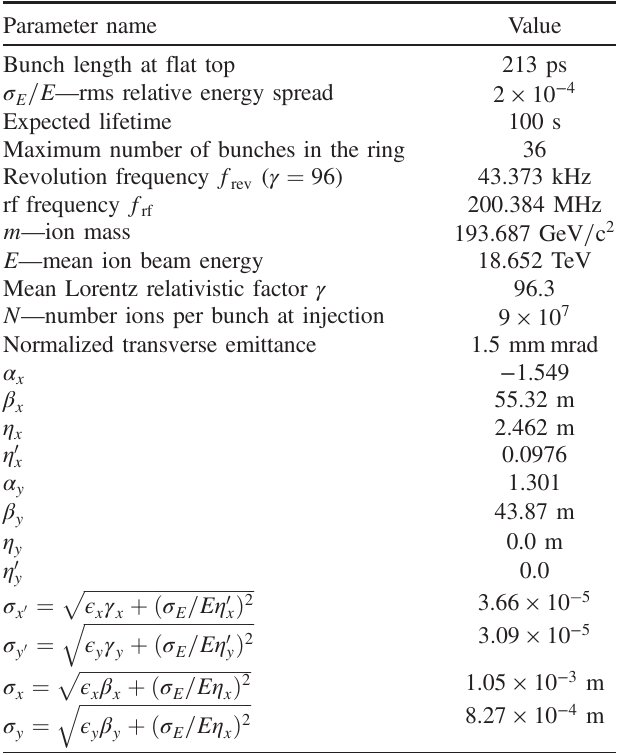
TABLE I. 208 Pb 79 þ bunch parameters in the SPS. Ions per bunch at injection are obtained from Ref. [34] for the fully stripped lead ions, scaled by the stripping efficiency of 208 Pb 79 þ extrapolated from experimental data and calibrated simulations [13,35,36]. The parameters α x;y , β x; y , and γ x;y ¼ ð 1 þ α 2 x;y Þ = β x;y are the Courant-Snyder parameters, η x;y represents the dispersion, and η 0 x;y is the angular dispersion. The beam spatial and angular spreads are denoted σ x;y and σ x 0 ;y 0 , respectively.